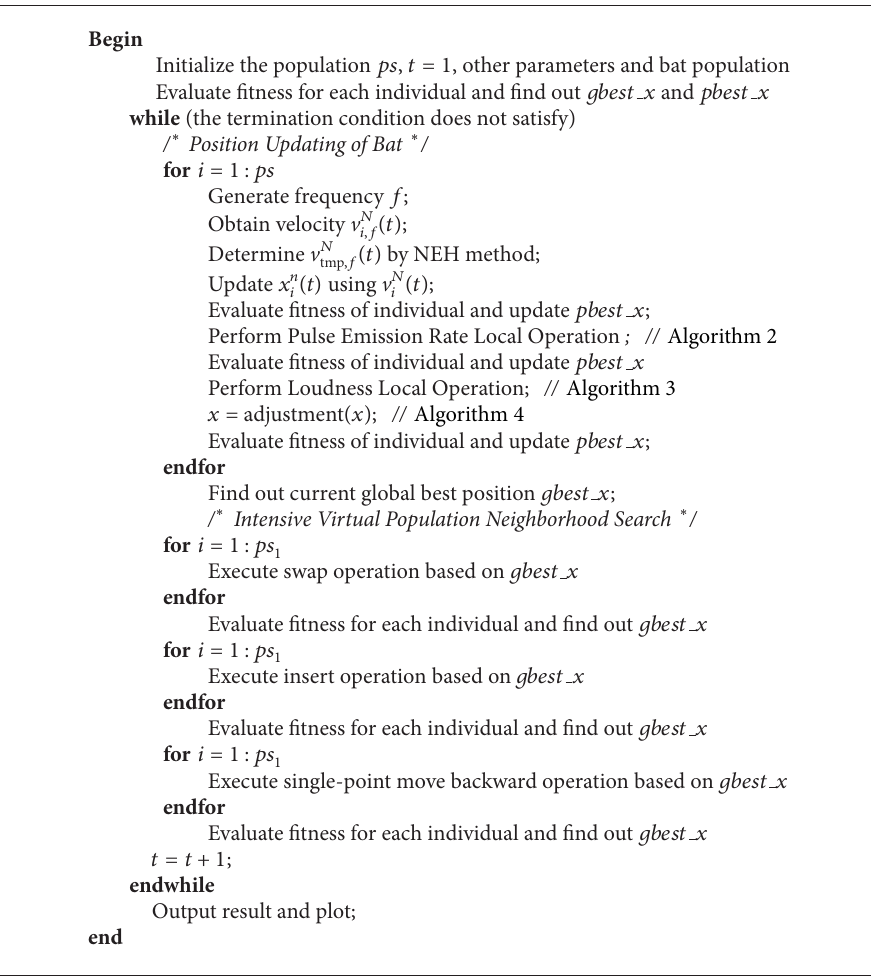
Algorithm 6: The DBA for